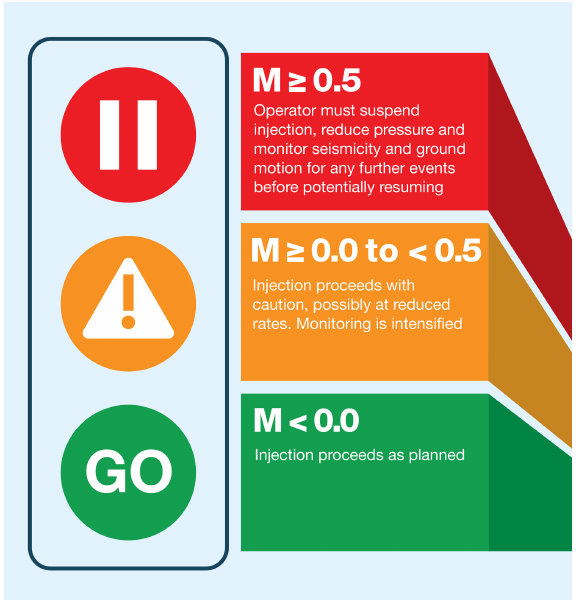
Figure 1. The UK’s traffic light system for regulating induced seis- micity from hydraulic fracturing activities for shale gas extraction, figure from the Department of Energy and Climate Change (DECC, 2013b), made by the OGA. The traffic light system is based on a risk mitigation technique originally developed for geothermal en- ergy production (Cremonese et al., 2015). It requires operators to monitor seismic activity in real time and, if seismic events are de- tected, to proceed or stop, depending on the magnitude ( M l ) of these events. Under this regulation, activities at Preston New Road were suspended several times during hydraulic fracturing in December 2018 (OGA,